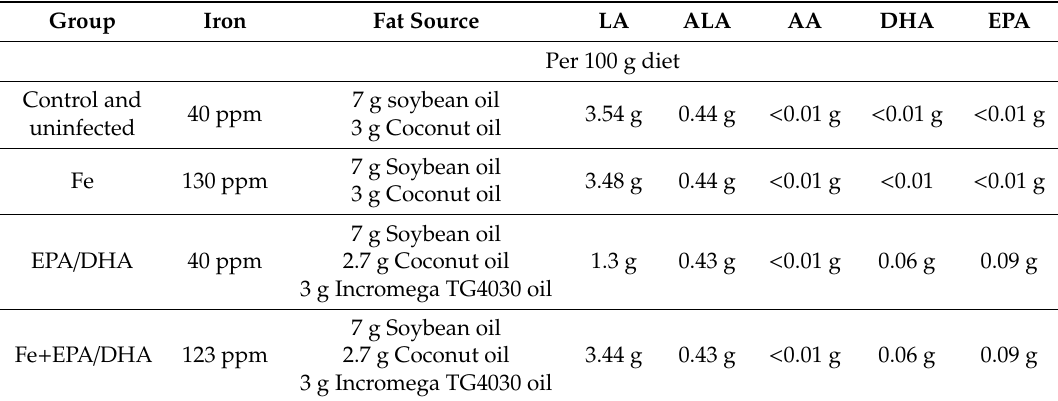
Table 1. Iron content, fat source, and fatty acid composition of the experimental diets 1 . Group